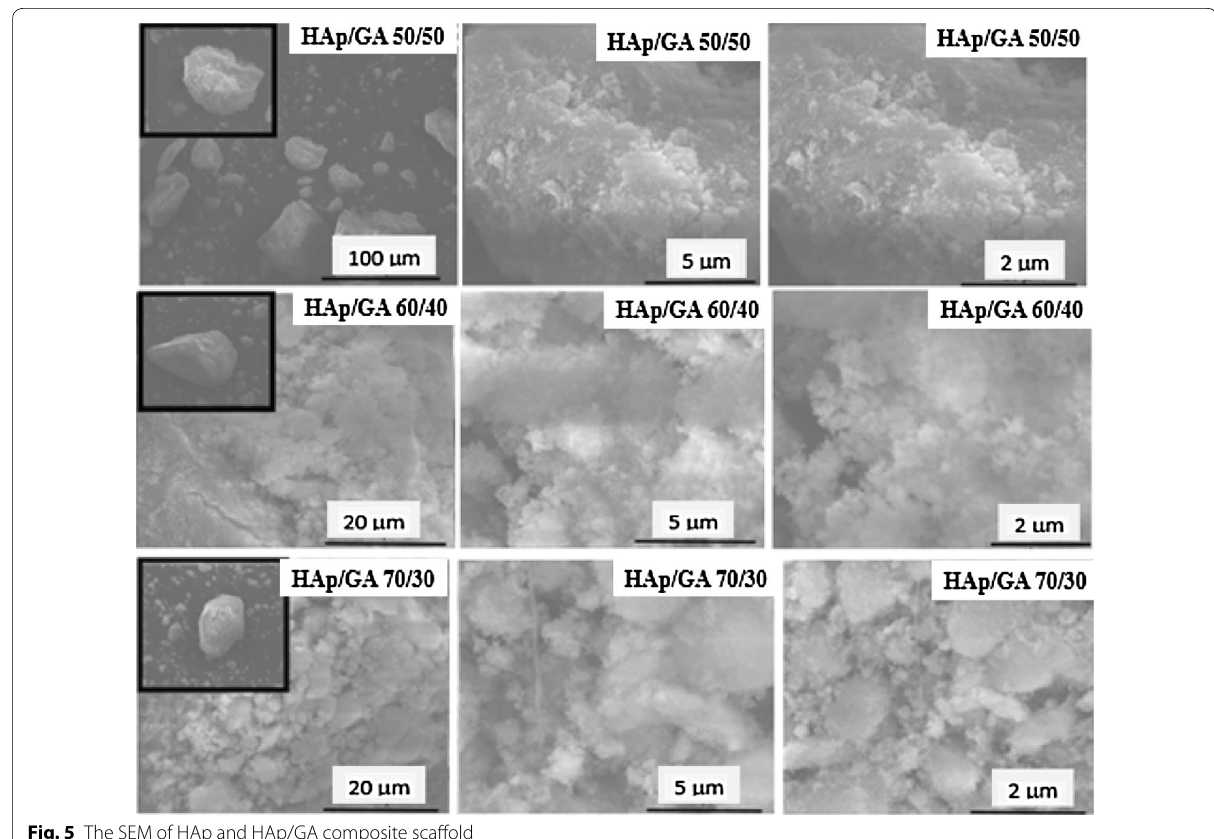
Fig. 5 The SEM of HAp and HAp/GA composite scaffold